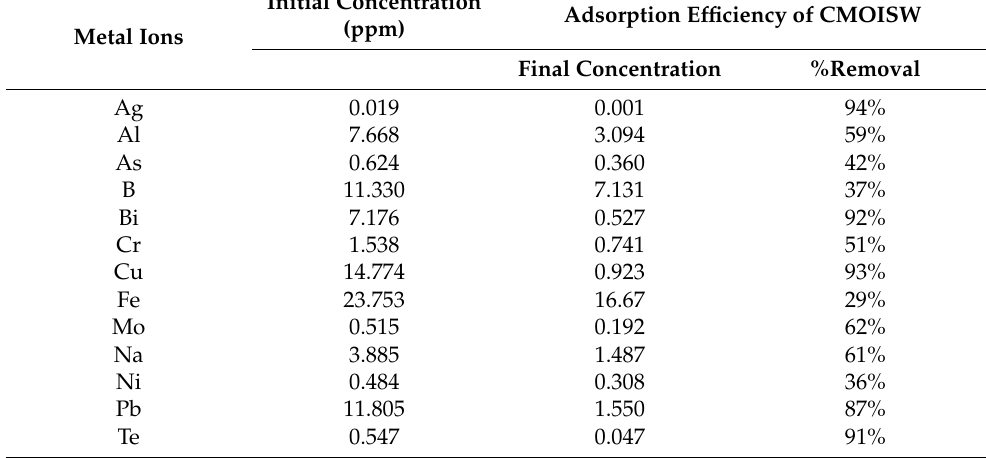
Table 1. Percent removal of metal ions from real sample of wastewater.